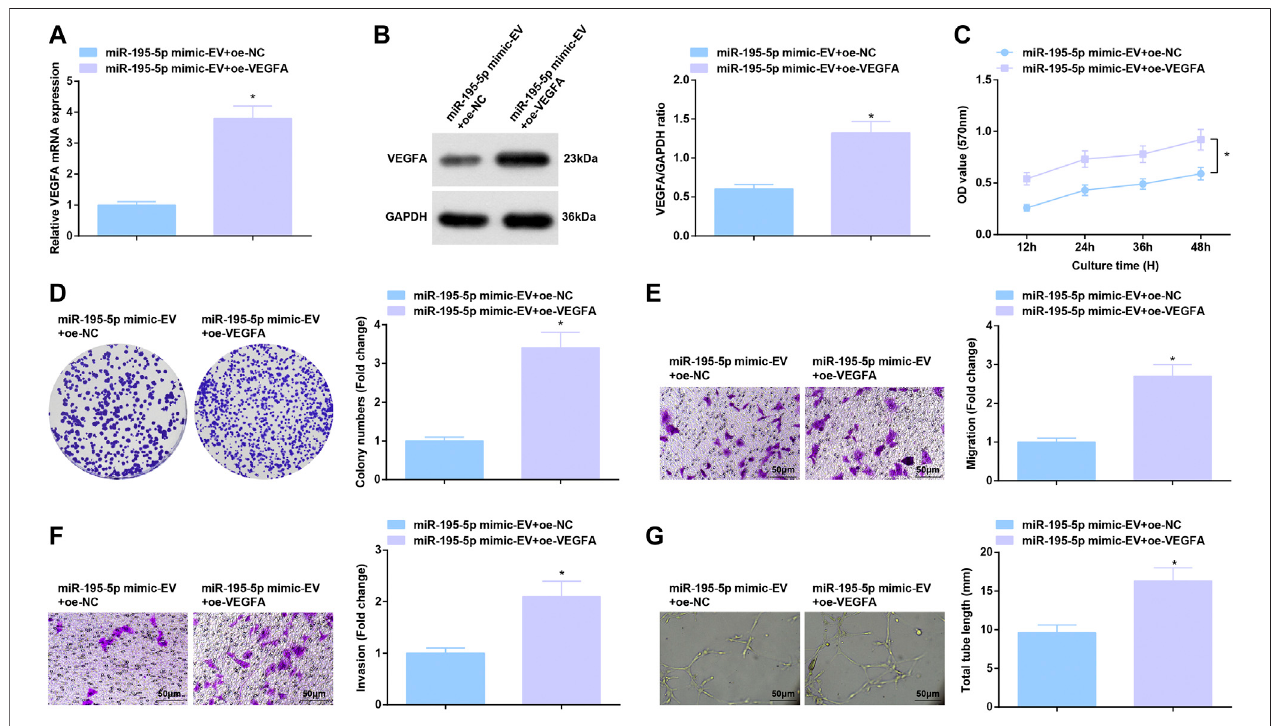
FIGURE 7 | Reversal of miR-195-5p-mediated effects on HUVECs by overexpressed VEGFA. (A,B) RT-qPCR and Western blot analysis of VEGFA expression in HUVECs after co-culture with EVs and transfection with overexpressed VEGFA; (C,D) Viability and colony formation ability of HUVECs after co-culture with EVs and transfection with overexpressed VEGFA; (E,F) Migration and invasion of HUVECs after co-culture with EVs and transfection with overexpressed VEGFA; (G) Angiogenesis of HUVECs after co-culture with EVs and transfection with overexpressed VEGFA. * p < 0.05 vs. the miR-195-5p mimic-EV + oe-NC